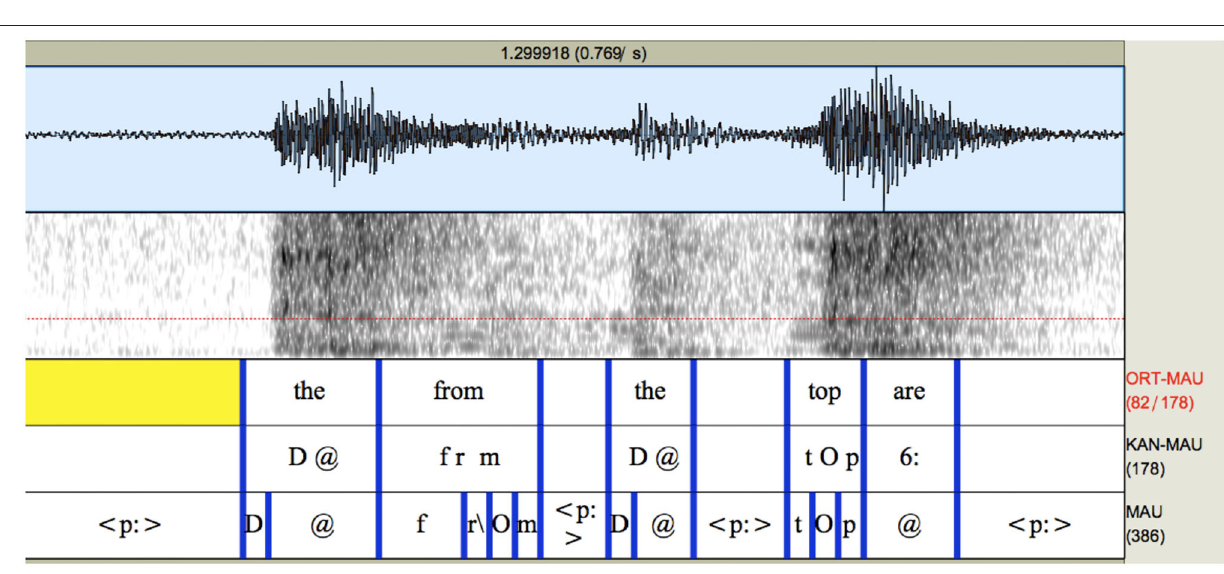
FIGURE 4 | Example 2 of system output with the poor quality recording using WEBMINNI,